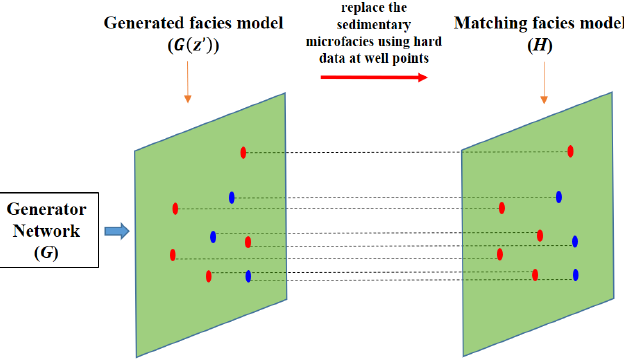
Figure 7. Schematic diagram of implementation of conditional loss function.